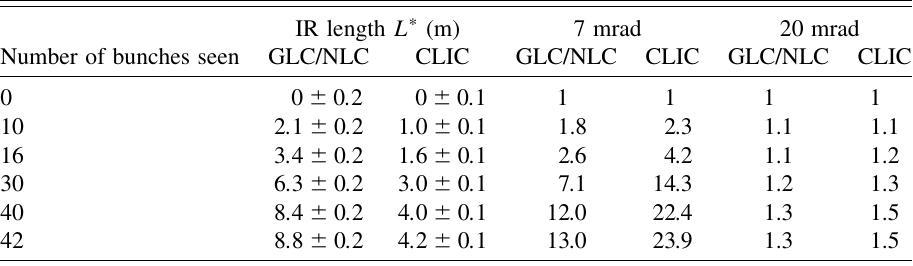
TABLE III. Vertical offset (expressed in beam size, (cid:1) ) of the beams at the end of the train for y different values of N (number of outgoing bunches seen by an incoming bunch) for two different crossing angle values (the other parameters have the values mentioned in Table I). N is proportional to the length during which the two beam are not shielded from each other in the interaction region